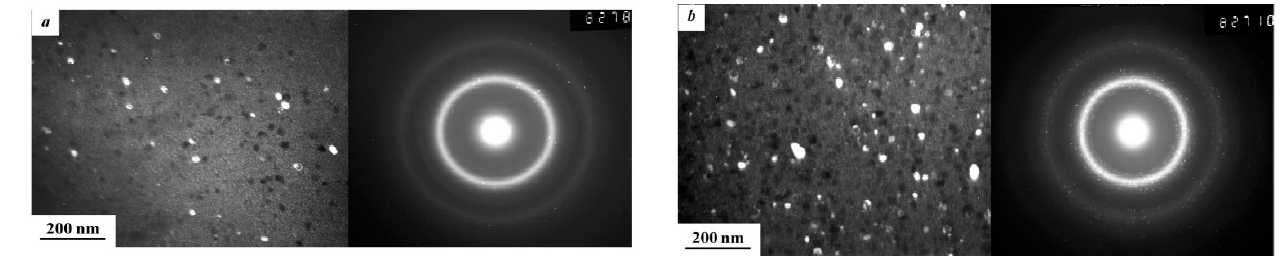
Figure 12. Dark-field images of the Fe 53.3 Ni 26.5 B 20.2 amorphous ribbons structure subjected to HPT to n = 3 ( a ) and n = 9 ( b ) and the corresponding selected area electron diffraction (SAED) patterns. Reprinted with permission from ref. [106]. Copyright 2020 MDPI.